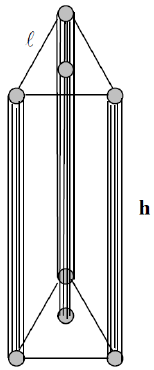
Figure 1. Right triangular body-centered prismatic model.